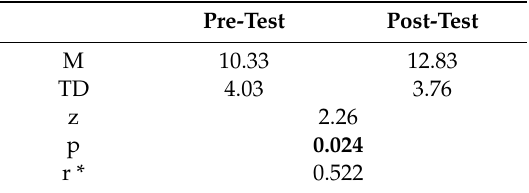
Table 13. Average (A), typical deviations (TD), Wilcoxon test results (Z), significance ( p ), and dMR value (r) of the total number of students in the pre-test and post-test in the self-control